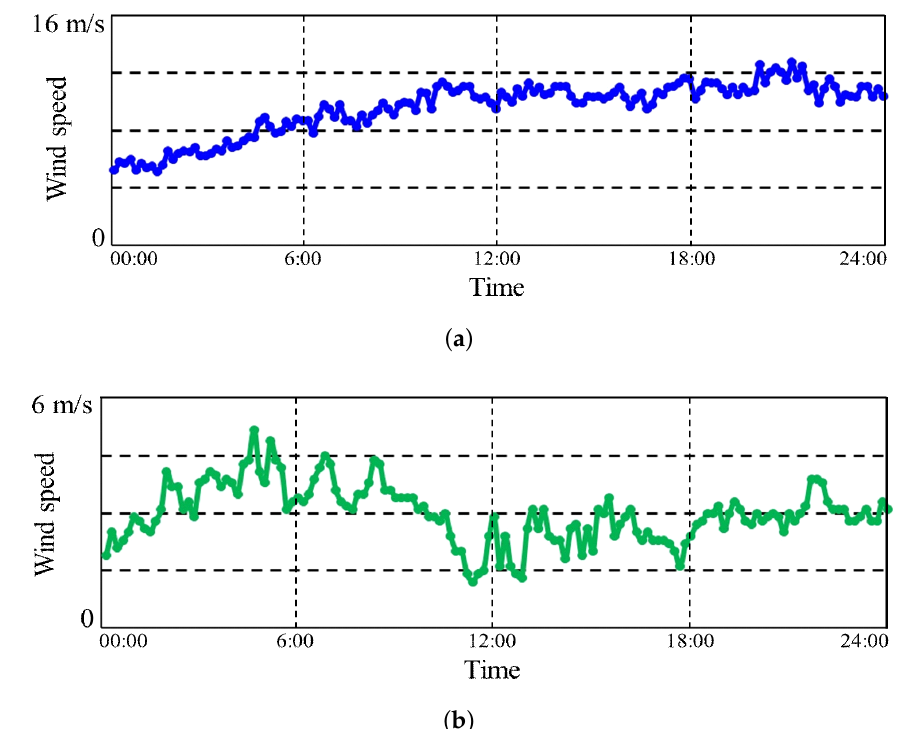
Figure 14. Wind speed profiles. ( a ) Wind speed profile with large speed fluctuation [23]; ( b ) wind speed profile with small speed fluctuation [24]. Table 5. Energy losses of the inrush current suppressors during the inrush current